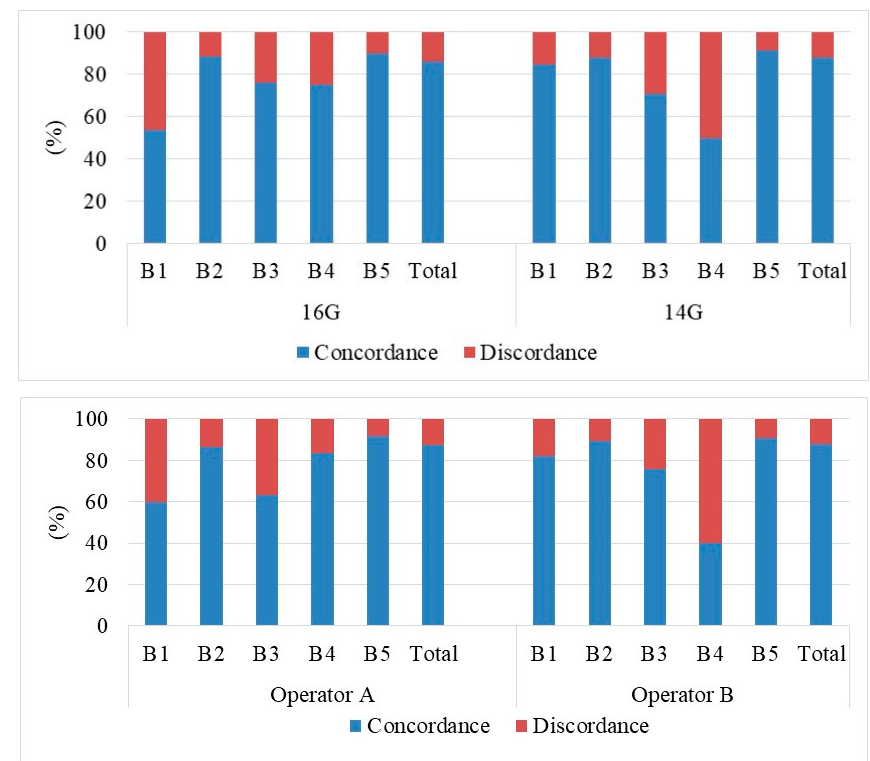
Figure 6. Assessment of the radio-pathological concurrence compared to the post-operative conclusive histology results of patients who underwent the CB procedure.